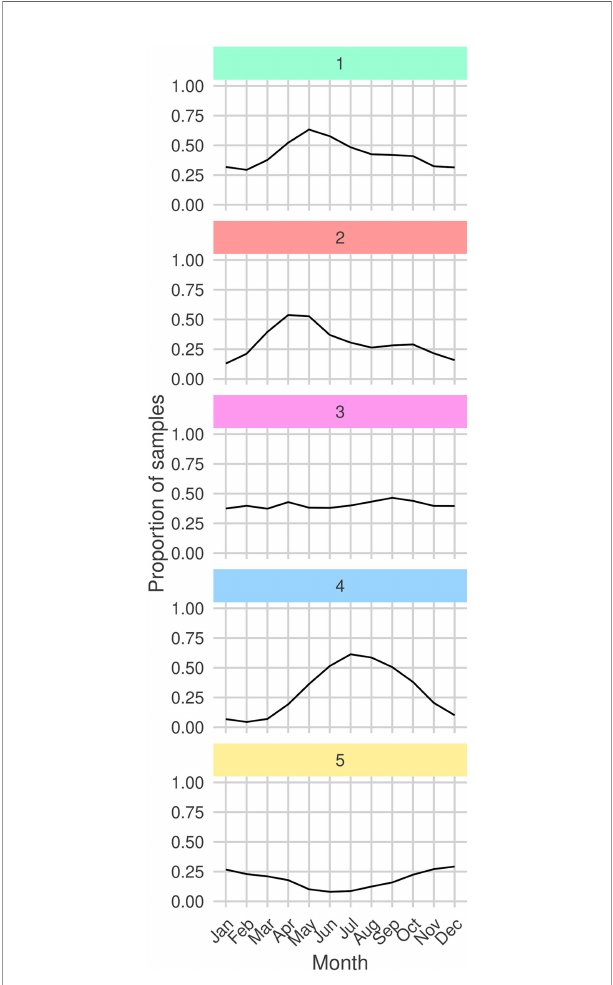
FIGURE 7 | Proportion of total samples taken in each month in which each sub-community is determined to be present (samples containing least 30% (rounded down) of a sub-community ’ s members). Facet colors and numeric- labels follow Figure 2